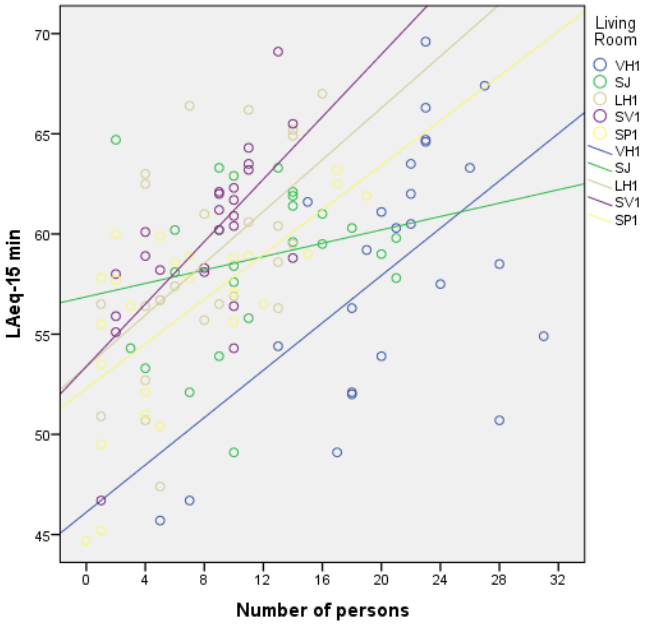
Figure 16. Scatter-plot of the L Aeq-15min scores as a function of the number of persons, considering the living rooms separately.